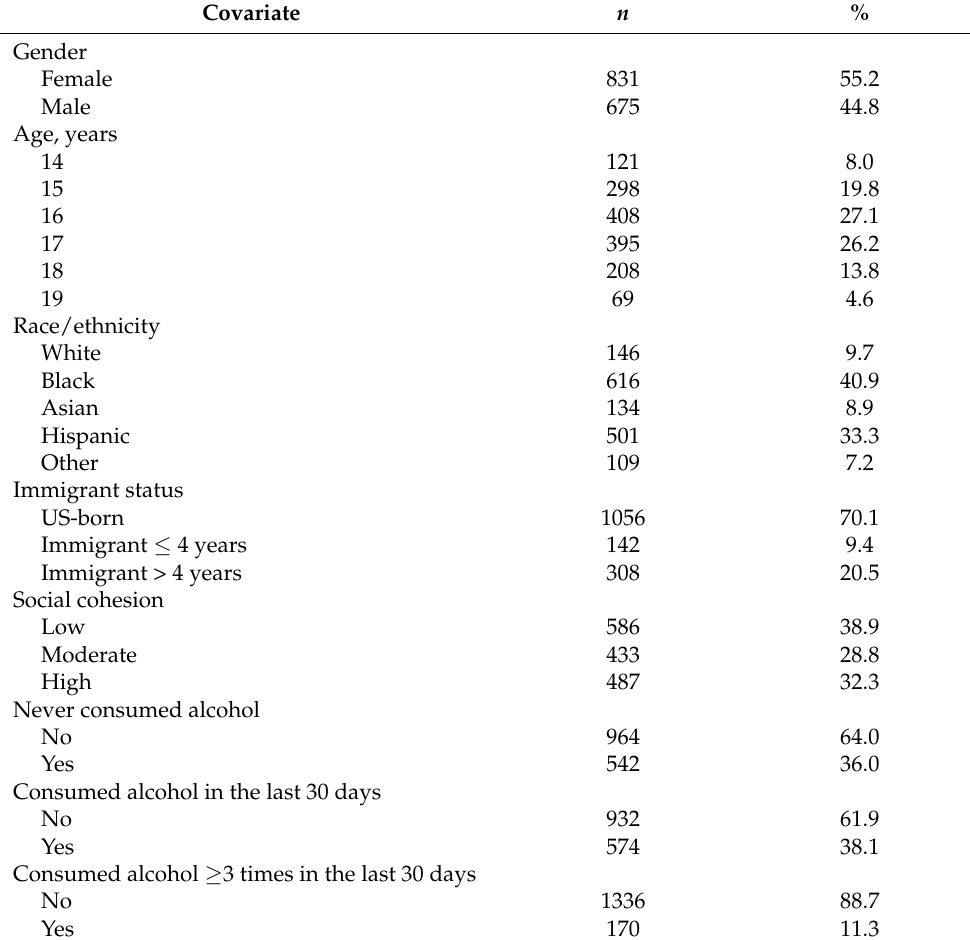
Table 1. Sociodemographic characteristics of adolescents: Boston Youth Study, 2008.